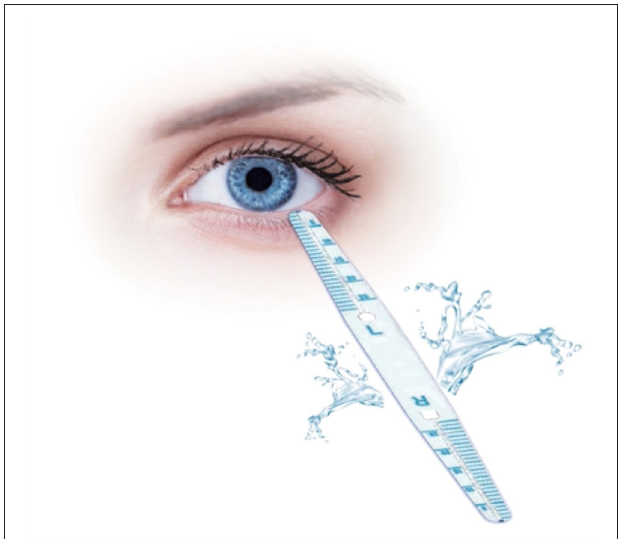
FIGURE 2 | SMTube. The method of strip meniscometry (SM) is using SMTube which is a thin strip (length: 85mm, width: 7mm, and height: 0.3mm) with a capillary absorber in the center and two columns of scale on both sides to measure the tear meniscus volume. The examiner held the center part of the strip and immersed the tip into the tear meniscus of the lower eyelid for 5s to absorb tears. The SMTube attached to the tear meniscus absorbed the tears into the ditch and the strip color turned blue, indicating the volume. At the end of 5s, the strip was taken out and the blue stained column length was measured. The length of the stained column for normal people was equal to or > 5mm, whereas it was < 5mm for DED patients.